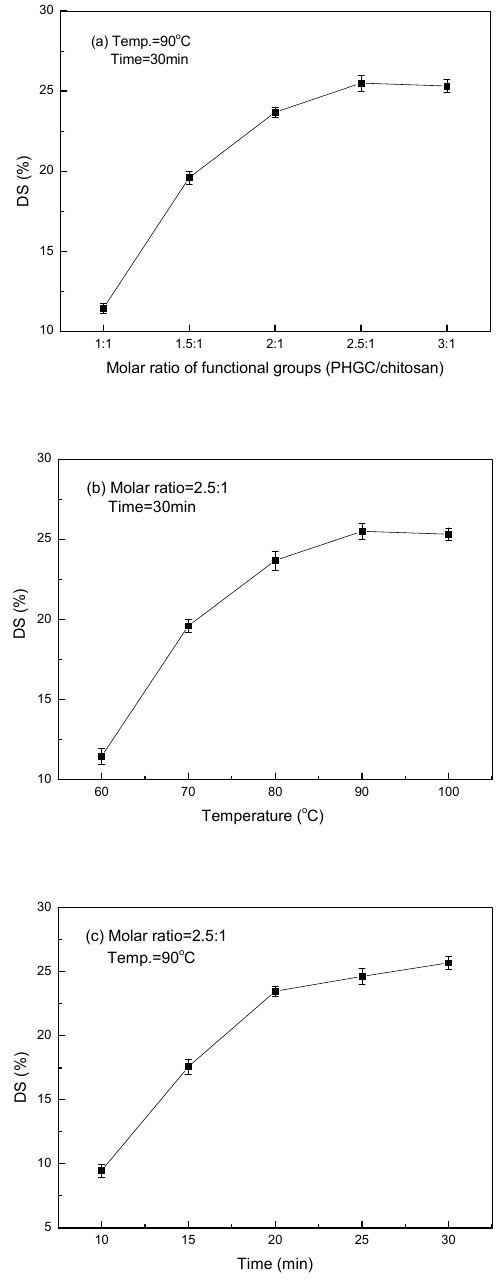
Figure 3. Effects of molar ratio ( a ), microwave temperature ( b ), and time ( c ) on the degree of substitution (DS) of GCS.